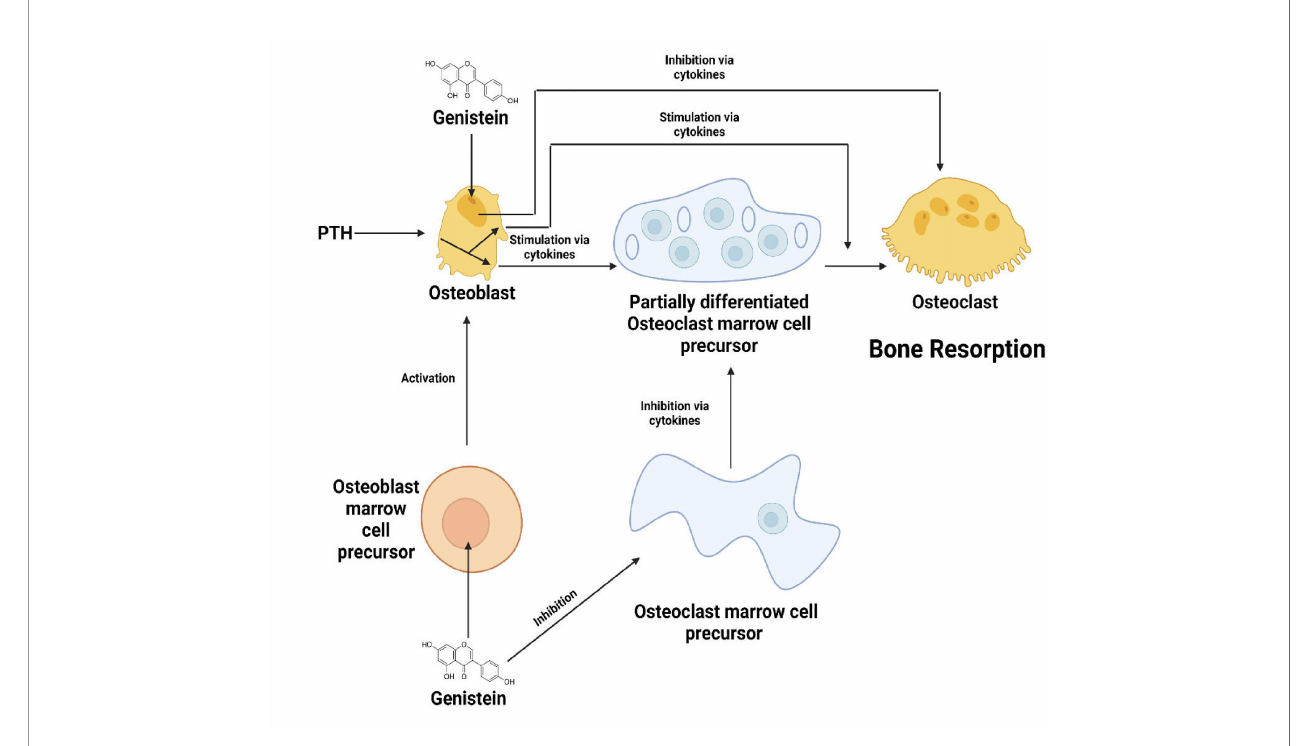
FIGURE 6 | Effects of genistein on osteoblasts, osteoclasts and their precursor